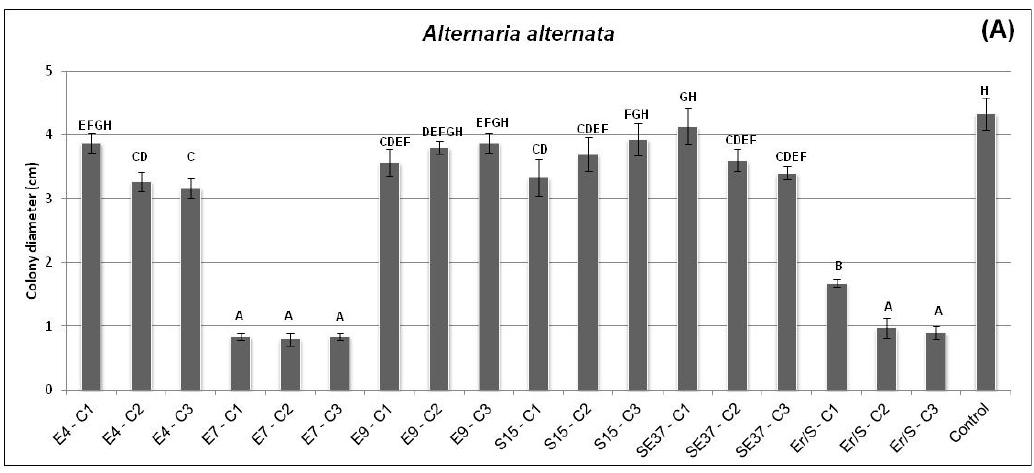
Figure 4. Inhibitory effect of the three concentrations, 1%, 10% and 20% v / v , of cell-free supernatant of endophytic bacteria (E4, E7, E9, S15, SE37 and Er-S as control strain) against fungal pathogens: ( A ) A. alternata , ( B ) C. cassiicola , ( C ) S. lycopersici . Values are means of three independent biological replicates and error bars represent the standard deviation, letters in common on the bars are not significantly different according to the Tukey test at p ≤ 0.05. 3 . 2.3. Effect of Volatiles from Endophytic Bacteria on Fungal Pathogen Growth The isolates E7, E9, S15, SE37 and Er-S released antifungal volatile compounds (VOCs) that inhibited the growth of A. alternata , C. cassicola and S. lycopersici after a 72–144 h incubation period (Figure 5).